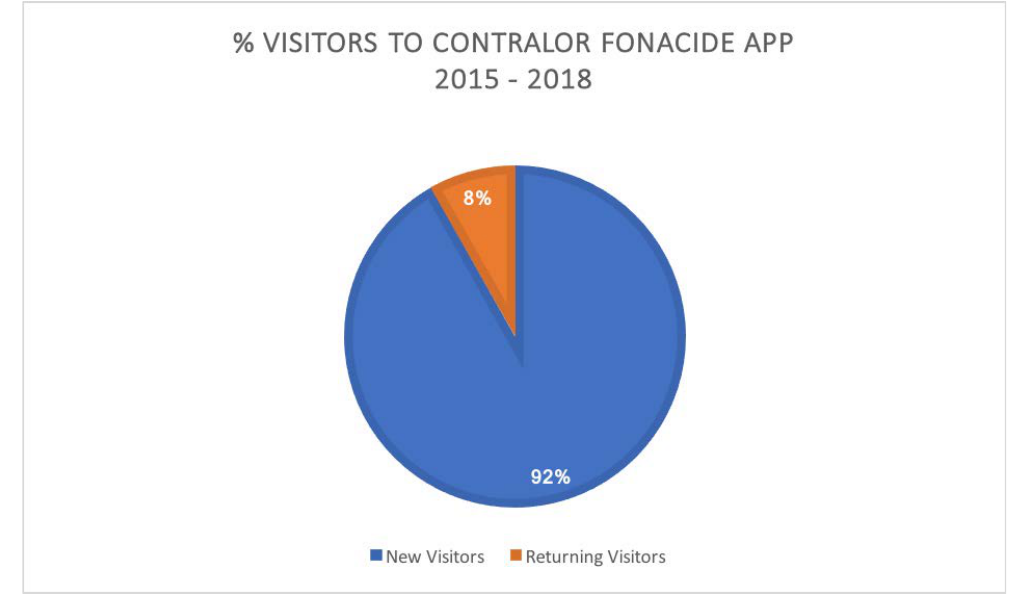
Figure 6: Percentage of Visitors to Contralor FONACIDE app